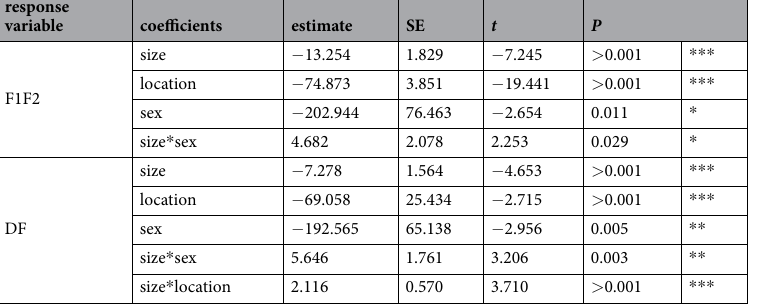
Table 1. Values of the final generalized linear mixed models for F1F2 and DF. F1F2 = Spacing between 1 st and 2 nd formant, DF = Dominant frequency, SE = standard error.